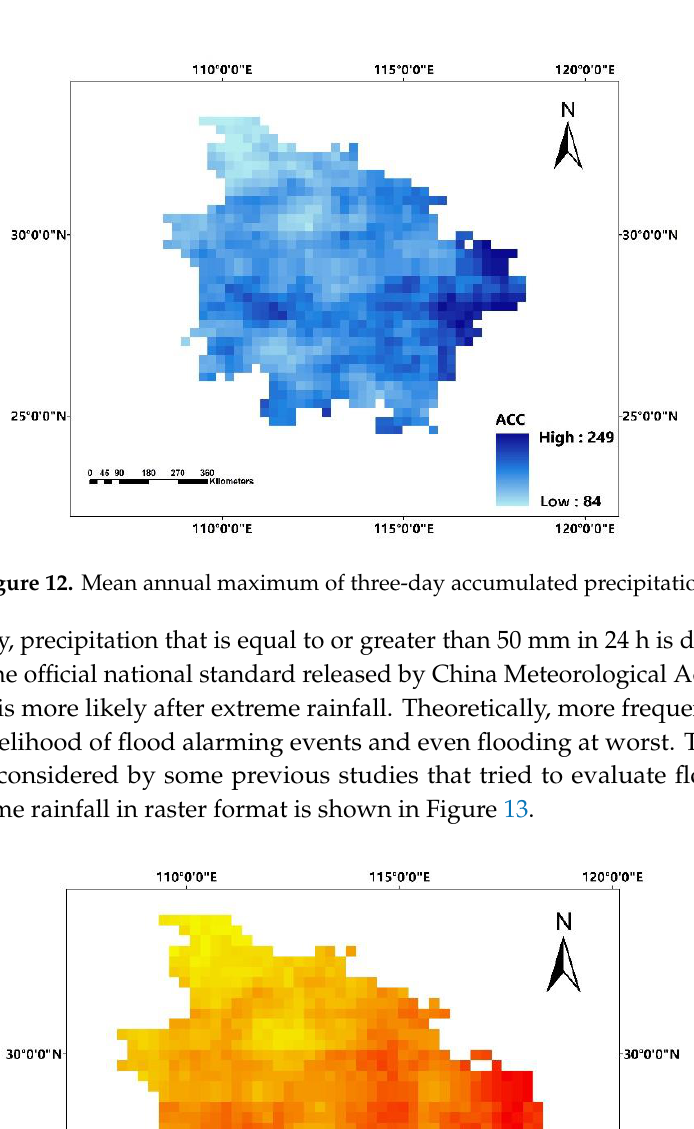
Figure 13. Frequency of extreme rainfall.